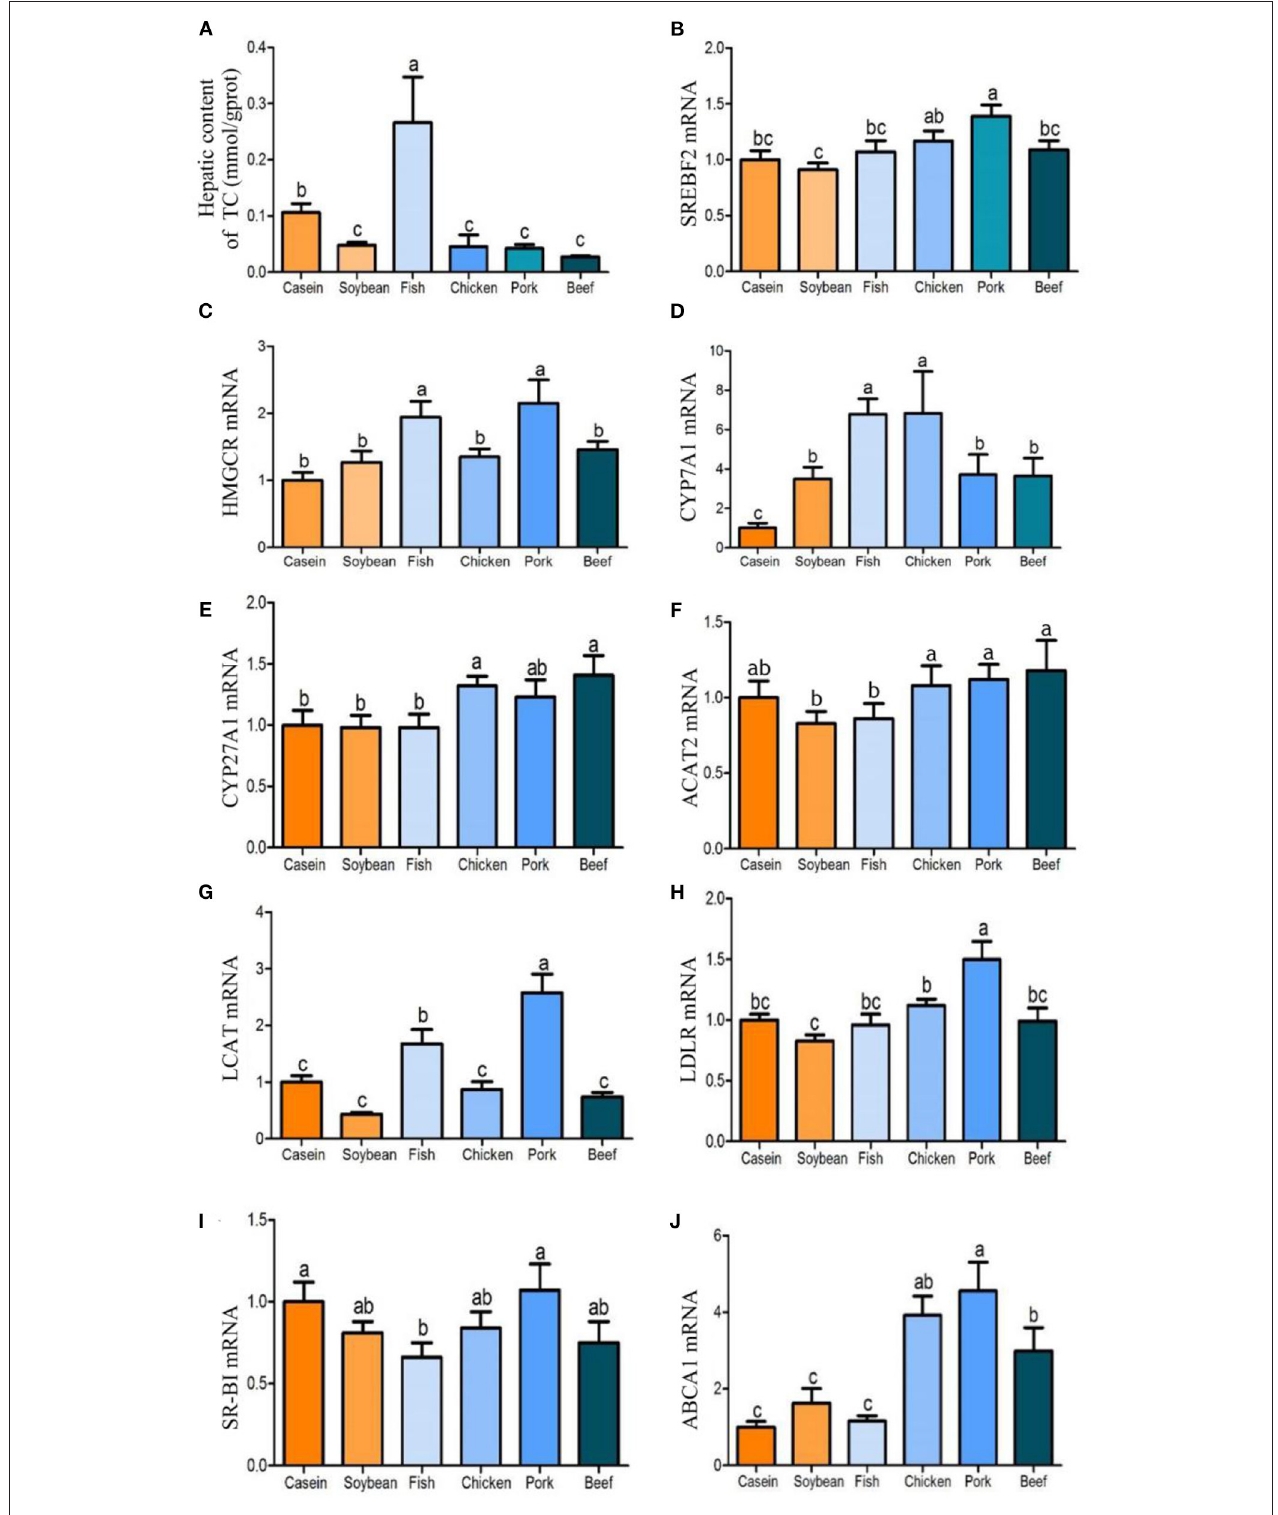
FIGURE 3 | Effects of dietary casein, soy and meat proteins on liver total cholesterol and cholesterol metabolism related genes. (A) Total cholesterol in the liver of rats fed different protein diets. (B–J) qPCR analysis of cholesterol metabolism related genes. Values are presented as the means ± SD. Groups were compared by one-way ANOVA followed by Duncan’s multiple range tests. Letters a–c represent significant differences between diet groups ( p < 0.05).